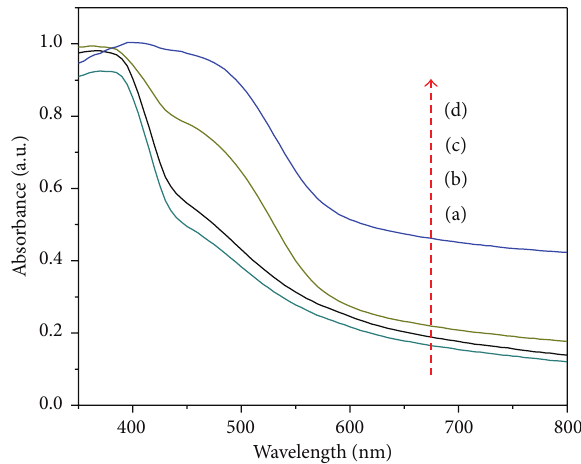
Figure 4: UV-vis DRS of the as-prepared samples: (a) carbon nitride; (b) CdS/CN-5; (c) CdS/CN-10; (d) CdS/CN-30.